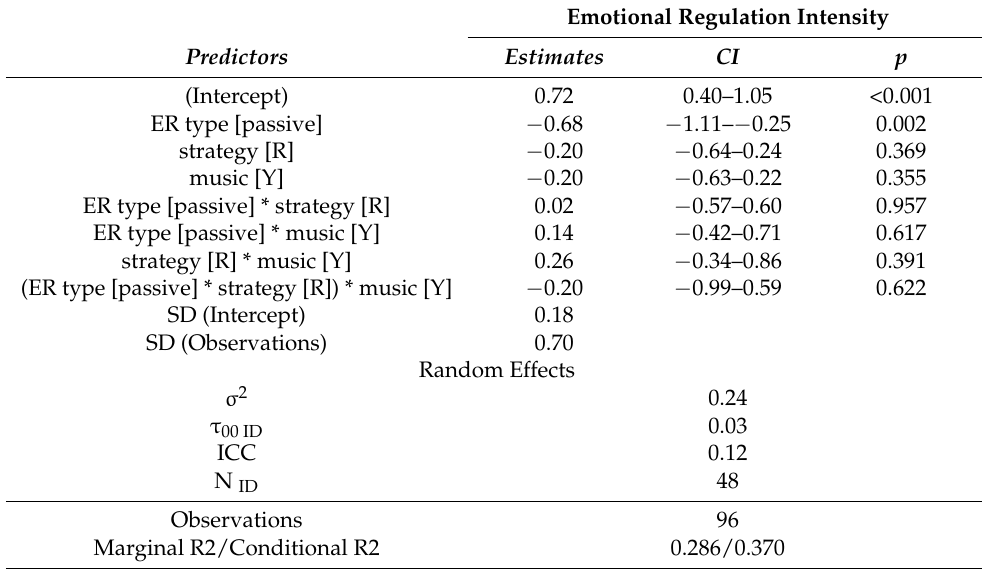
Table 4. Effects of ER type, music, and strategies on emotional regulation